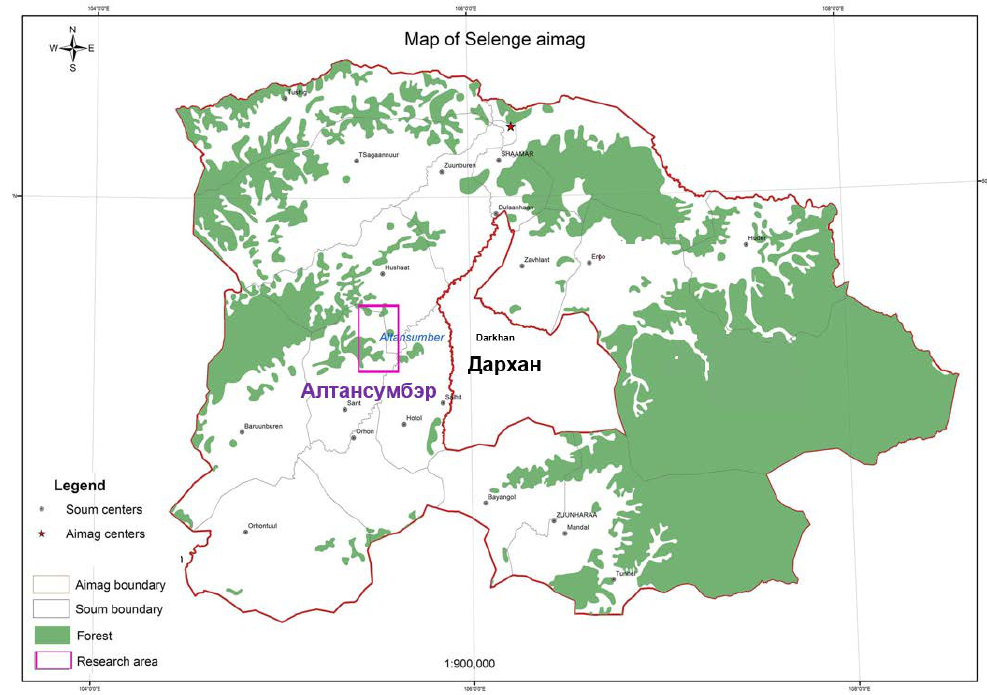
Figure 1. Map of the Selenge aimag with the research area Altansumber (Institute of Geography-Geoecology, Mongolian Academy of Sciences; [24]).